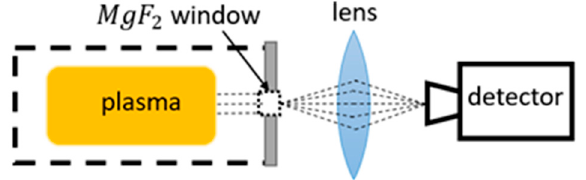
Figure 8. Schematic of an emission spectroscopy technique.